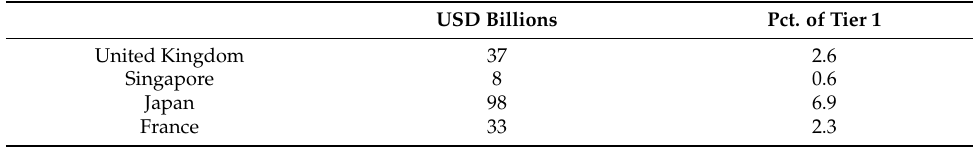
Table 3. U.S.-headquartered banks’ exposure to banks in *.